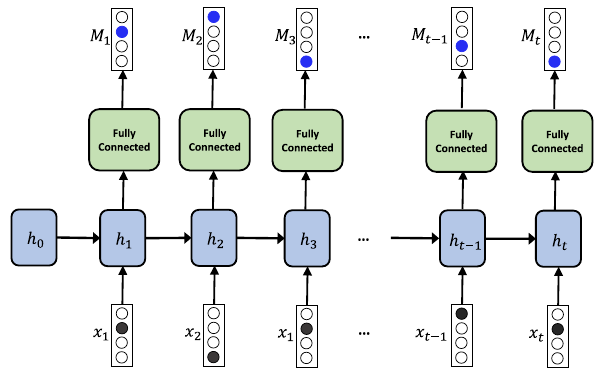
Fig. 6 Architecture for standard